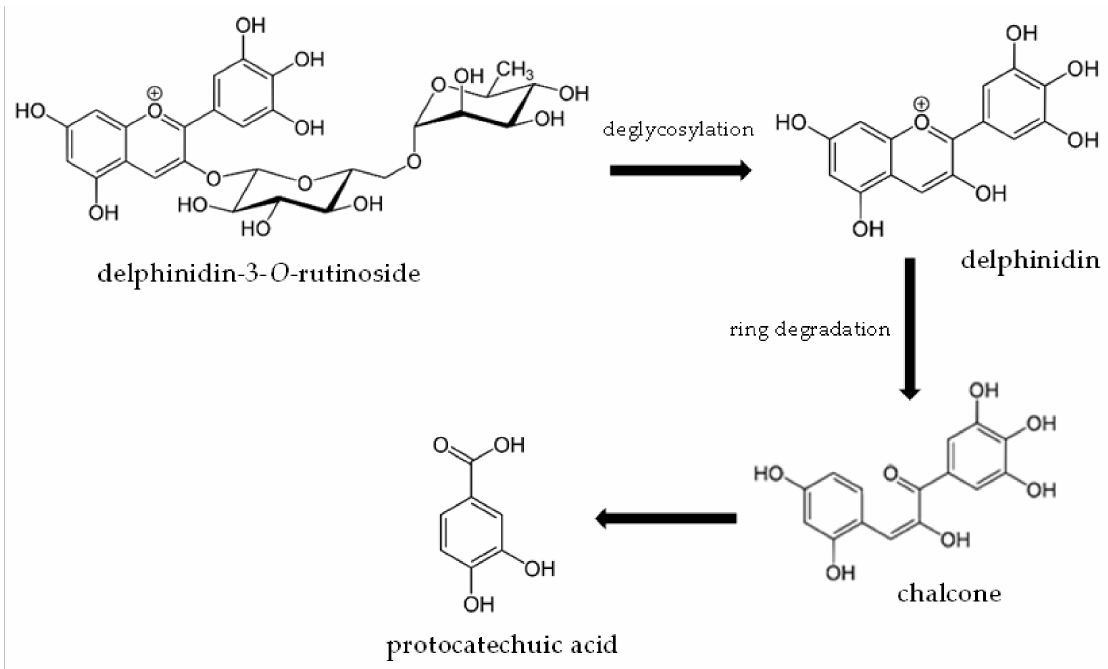
Figure 7. Proposed pathway for the formation of protocatechuic acid from delphinidin-3 -O- rutinoside in the gastrointestinal